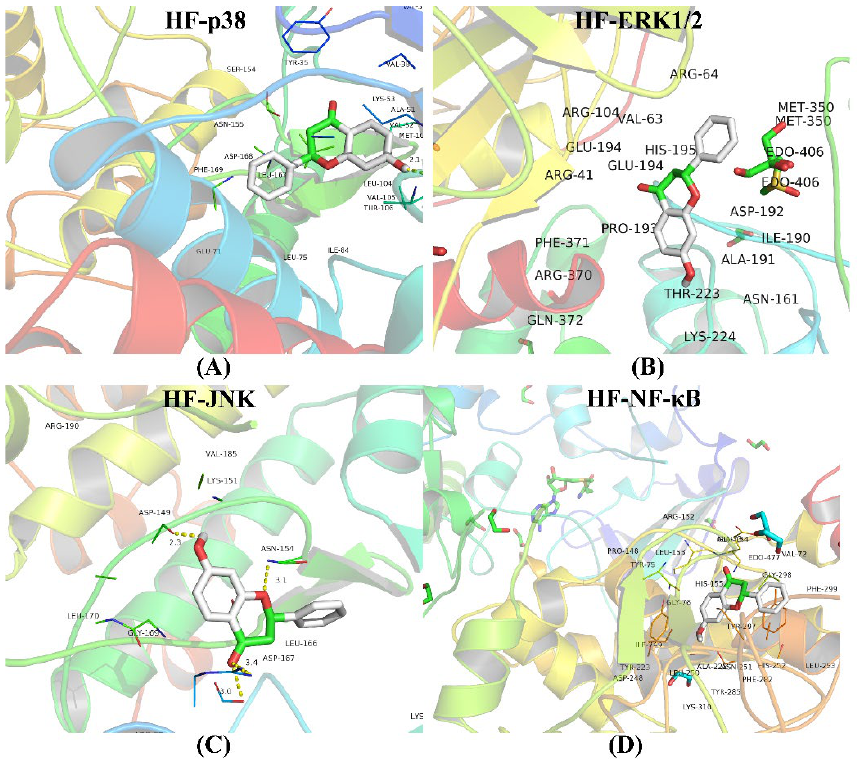
Figure 10. Molecular docking. ( A ) The combination between HF and p38. ( B ) The combination between HF and ERK1/2. ( C ) The combination between HF and JNK. ( D ) The combination between HF and NF- κB. The binding affinities are all less than 5 kcal/moL.